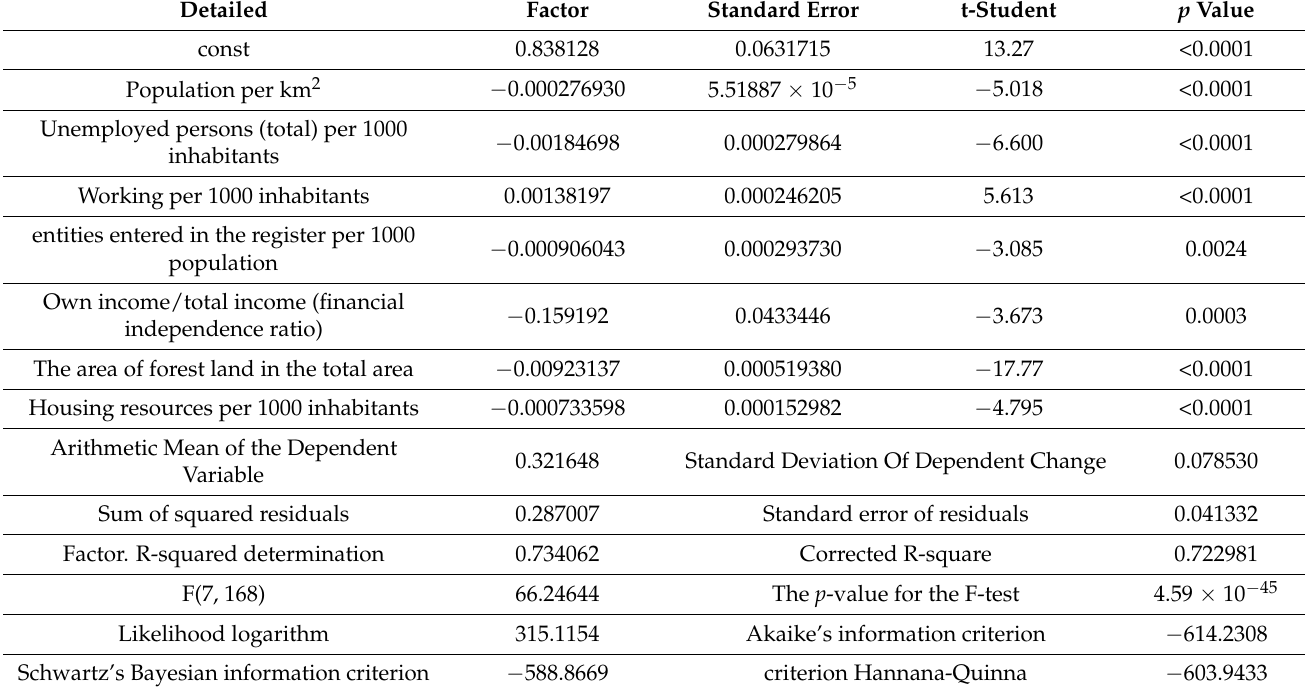
Table 7. Results of the regression analysis between the agricultural potential and the variables of the voivodeship develop- ment in